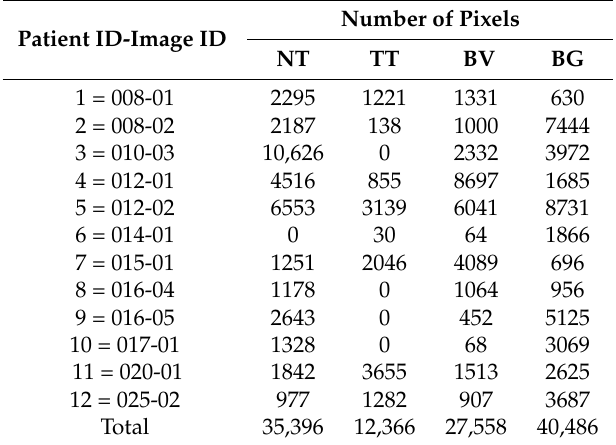
Table 1. Summary of the hyperspectral (HS) images. NT is normal tissue, TT is tumor tissue, BV is blood vessel, BG is